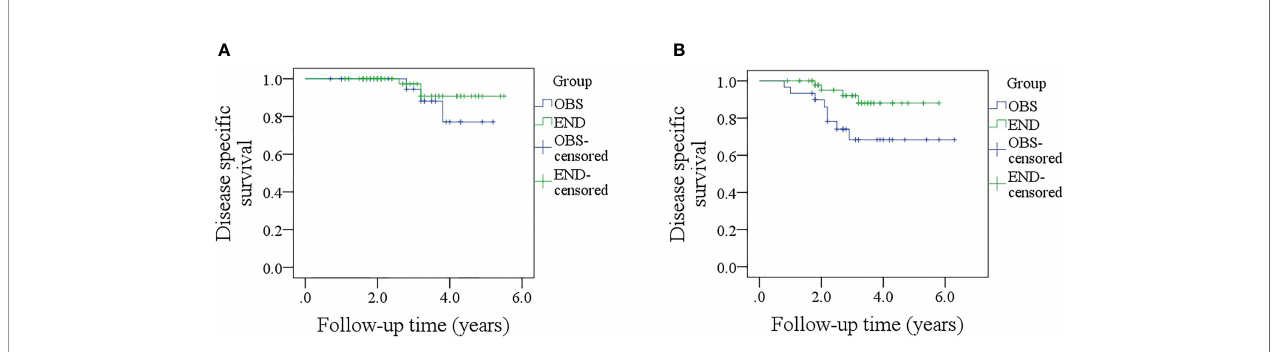
FIGURE 5 | (A) Comparison of disease-speci fi c survival between the elective neck dissection and observation groups in patients with a sonographic depth of invasion <4.0 mm (p = 0.381); (B) Comparison of disease-speci fi c between the elective neck dissection and observation groups in patients with a sonographic depth of invasion ≥ 4.0 mm (p